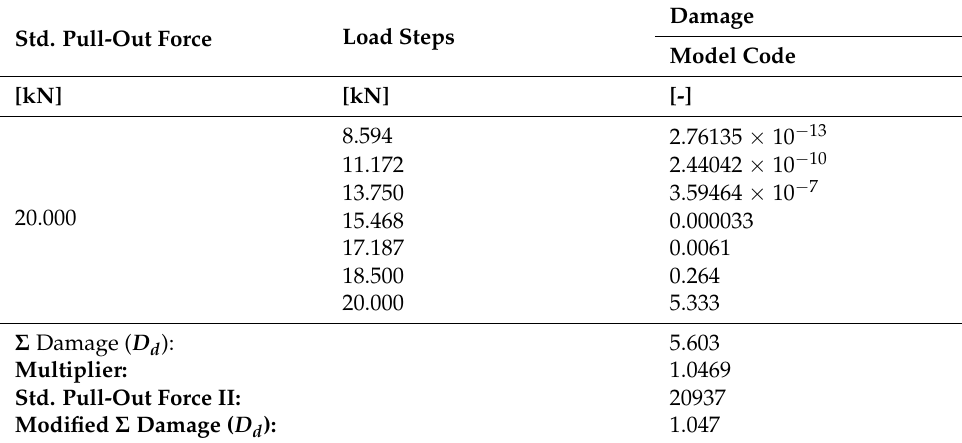
Table 11. Damage calculation according to